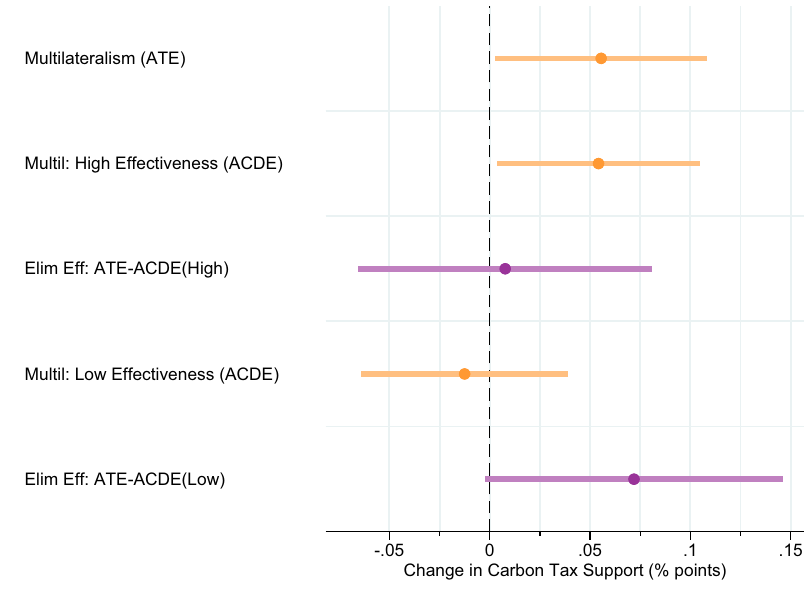
Fig. 1 | The effect of multilateralism on carbon tax support and the effective- ness mechanism ( N =6000). a The fi gure shows the proportion of individuals supporting the introduction of a domestic carbon tax by randomly assigned mul- tilateralism and effectiveness conditions. b The fi gure reports the average treat- ment effect (ATE), average controlleddirect effects (ACDE),and eliminated effects (EE) of multilateralism by randomly assigned effectiveness condition (High=high